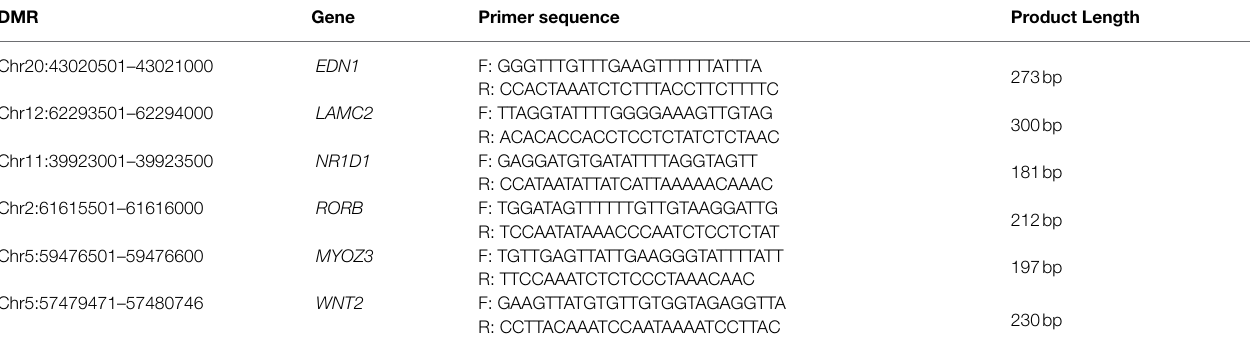
TABLE 3 | Primers for amplicon of bisulfite sequencing PCR. DMR Gene Primer